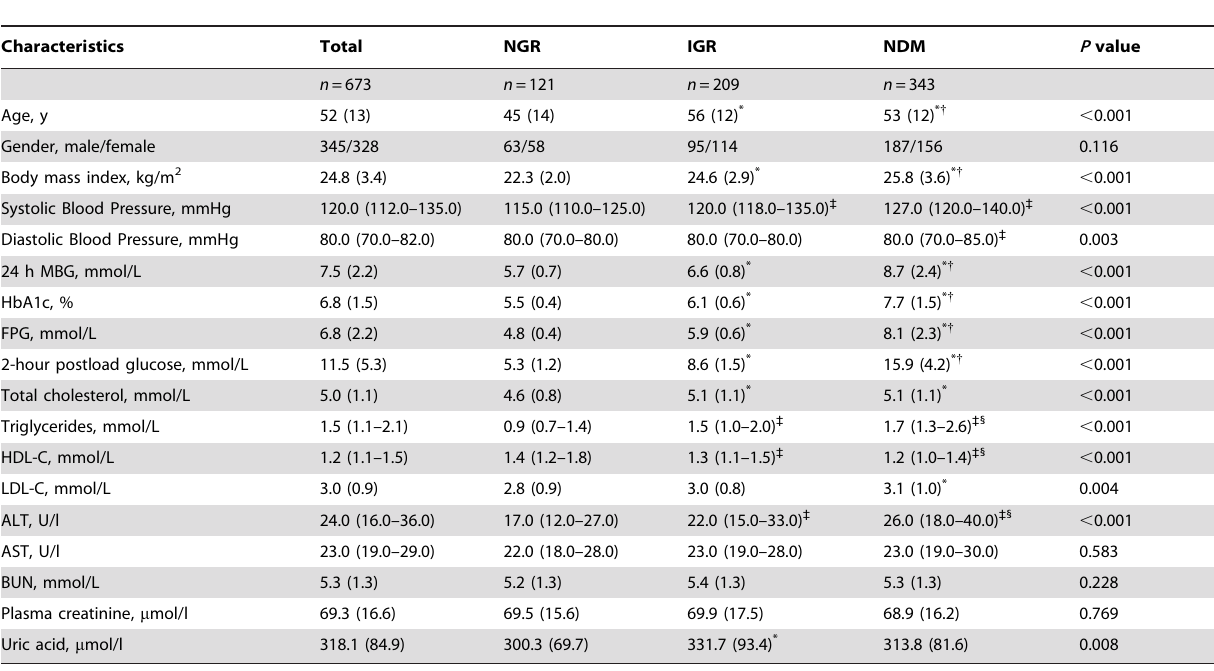
Table 1. Clinical characteristics at baseline of study